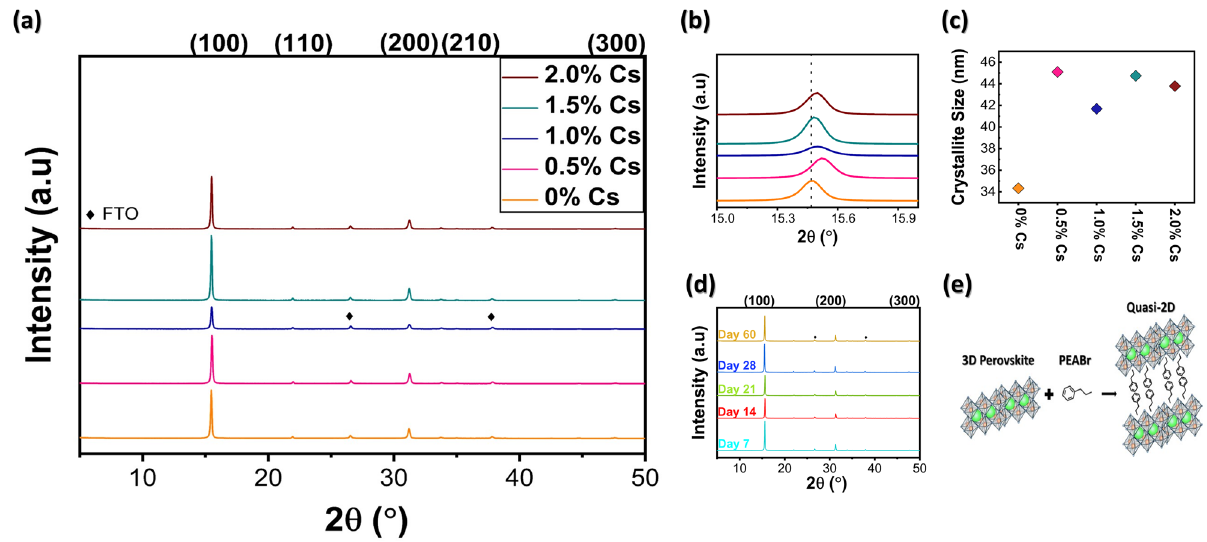
Figure 1. ( a ) XRD patterns of (PEA) 2 (Cs x MA 0.61-x FA 0.39 ) 39 (Pb) 40 (Cl 0.88-0.32x Br 0.12+0.32x ) 121 with different Cs contents. (110) and (210) planes belong to small amount of FAPbCl 3 . ( b ) XRD spectra of 0% Cs, 0.5% Cs, 1.0% Cs, 1.5% Cs, and 2.0% Cs at the 2θ from 15° to 16°. ( c ) Crystallite sizes of 0% Cs, 0.5% Cs, 1.0%, 1.5% Cs, and 2.0% Cs. ( d ) XRD spectra of 1.5% Cs showing stability of 60 days in moisture environment. ( e ) Diagram of quasi-2D, low-dimensional perovskite